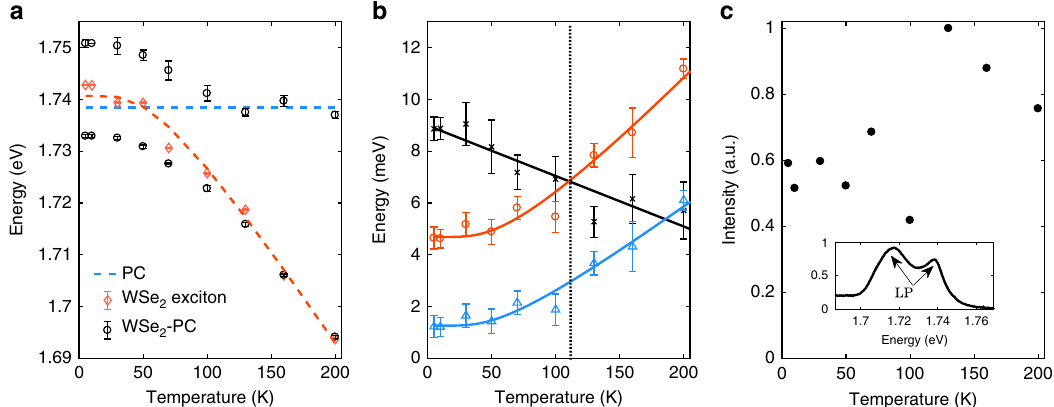
Fig. 3 Temperature dependence of the WSe 2 -PC system. a The temperature dependence of the exciton, cavity, and polariton energies. The exciton energy E exc ( T ) is measured from the weakly coupled TM excitons (red diamonds) and is extracted by fi tting the PL spectrum using Gaussian line shape. Temperature dependence of the exciton is fi tted by Eq. (6) (dashed blue line). The cavity energy E cav ( T ) is found to be approximately constant with temperature and indicated by the dashed blue line. The polariton energies E LP,UP ( T ) (black circles) are extracted by fi tting the PL spectra at k x = 3.1 μ m − 1 , k y = 0 μ m − 1 using Gaussian line shape. They anti-cross and split from the exciton and PC mode energies at 100 K and below, showing strong coupling in this range. All the error bars are extracted by least square data fi tting. b The strong coupling to weak-coupling transition measured by the temperature ffiffiffiffiffiffiffiffiffiffiffiffiffiffiffiffiffiffiffiffiffiffiffiffiffiffiffiffiffi p ð γ 2 þ γ 2 Þ = 2 dependence of g (black stars), (red circles), and ( γ exc − γ cav )/2 (blue triangles). The red and blue lines are fi ts by Eq. (7) for γ exc while γ cav ffiffiffiffiffiffiffiffiffiffiffiffiffiffiffiffiffiffiffiffiffiffiffiffiffiffiffiffiffi p exc cav ð γ 2 þ γ 2 Þ = 2 is approximately constant with temperature. g drops to below at about 115 K, showing the transition to the weak-coupling regime as exc cav indicated by the dashed line. Rabi splitting persists up to about 185 K, till g becomes smaller than ( γ exc − γ cav )/2. All the data points are extracted by fi tting the PL spectrum using Gaussian line shape, and the error bars are extracted by least square data fi tting. c Temperature dependence of the integrated PL intensity of the PC-WSe 2 polariton, showing only mild change in intensity. The inset shows the spectrum at 10 K integrated over θ x = − 30° to 30° and over the spectral range shown. The higher energy side shoulder corresponds to exciton-like LP emission at large θ x where the density of states is